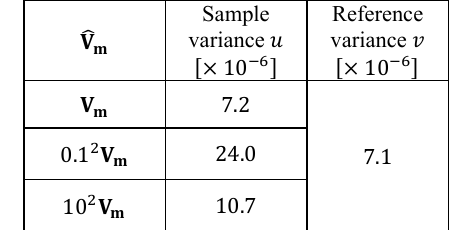
Table 2. Comparison example of sample variances 𝑢 with the reference variance 𝑣